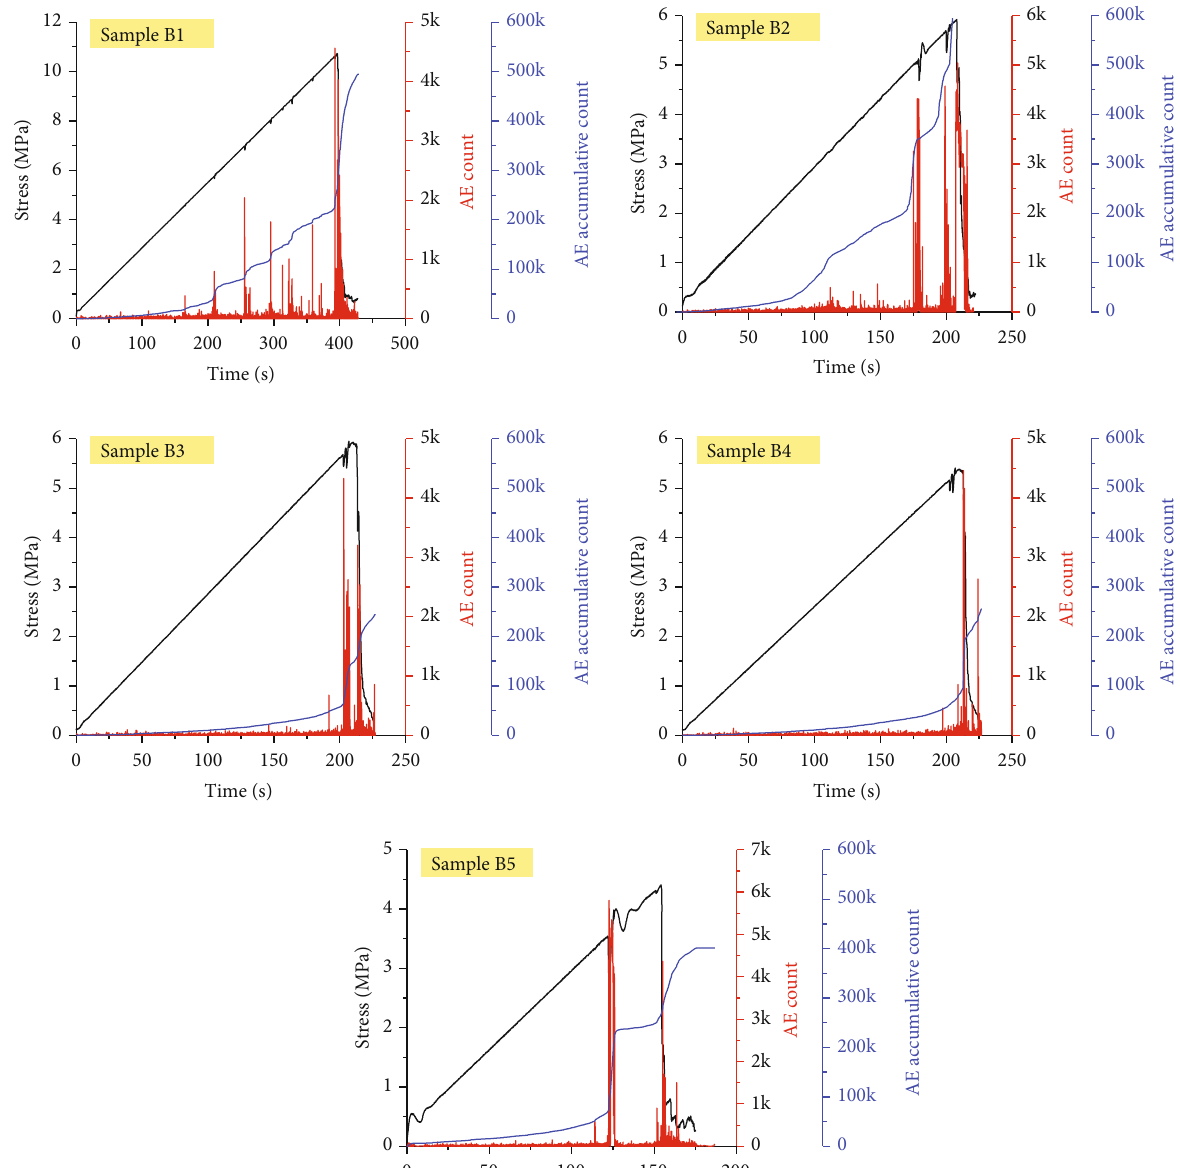
Figure 6: The relationship among variation of AE count, accumulated AE count, and stress with respect to